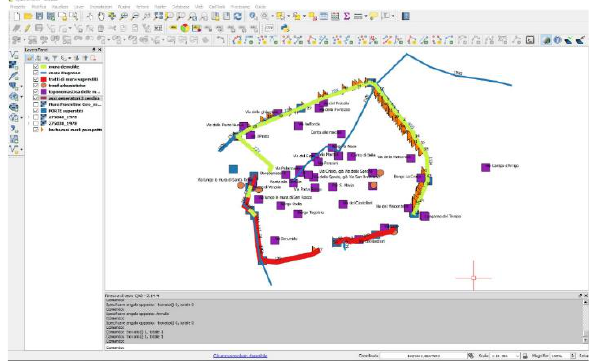
Figure 13. Geometrical filling of the attribute table.